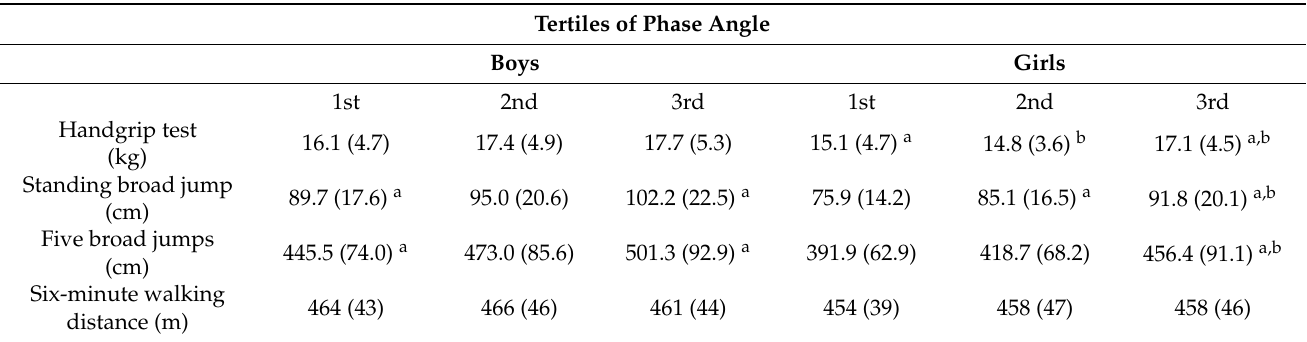
Table 3. Health-related fitness tests expressed for tertiles of phase angle in boys and girls.